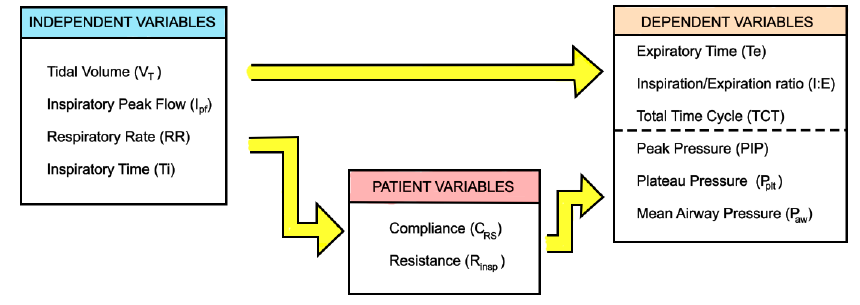
Figure 2. Independent and dependent variables in VC ‐ CMV mode, adapted from [5].